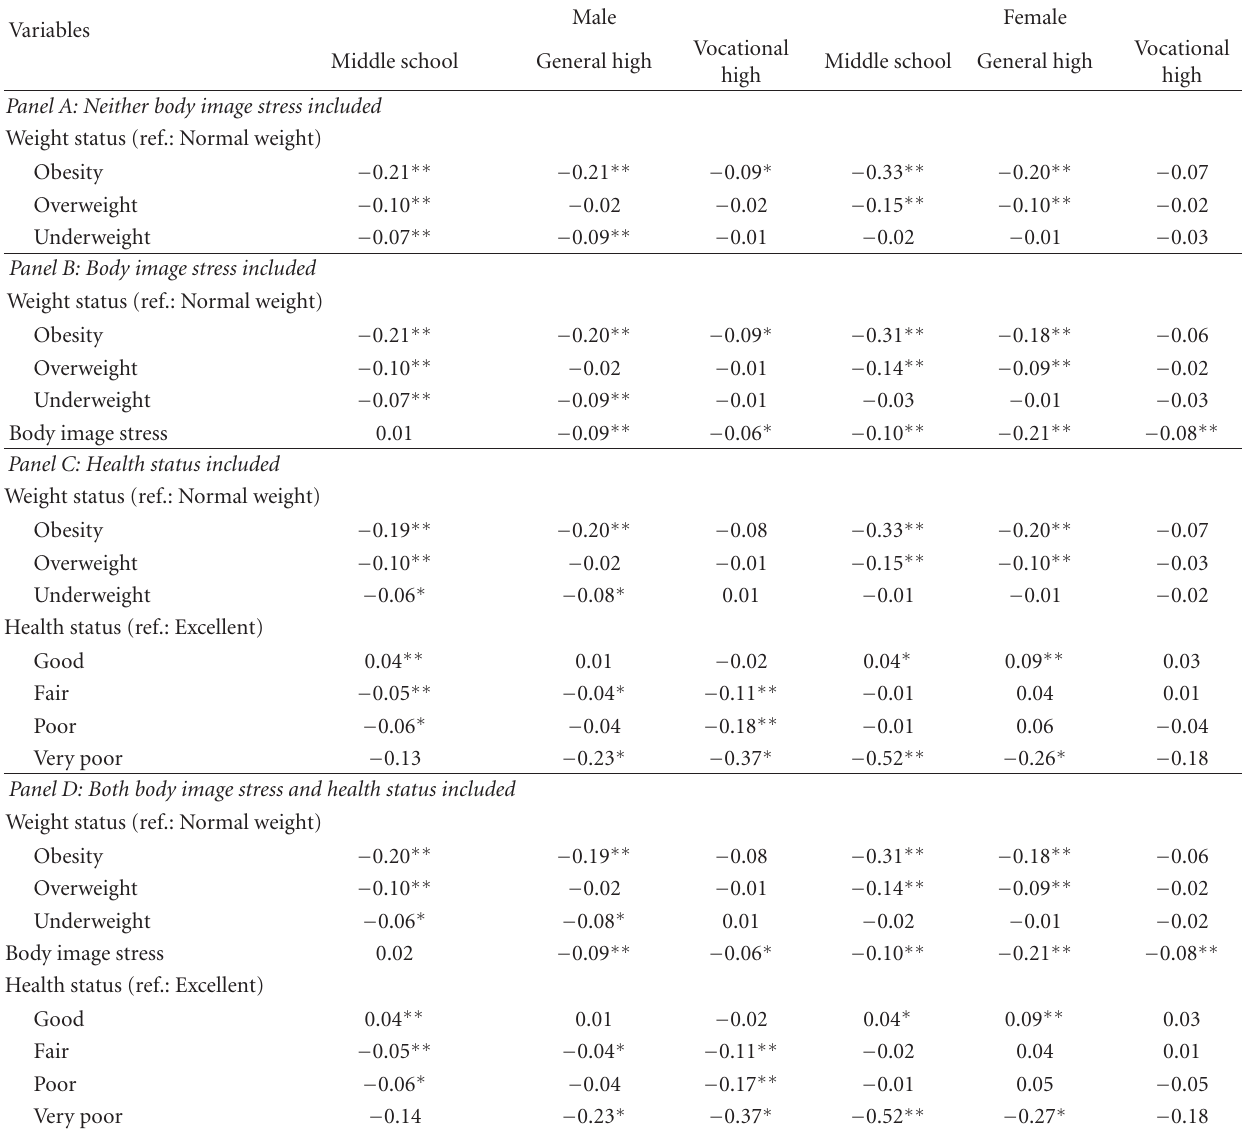
Table 3: Ordered probit regression analysis of self-reported school performance † . Male Female Variables Vocational Middle school General high Middle school General high high